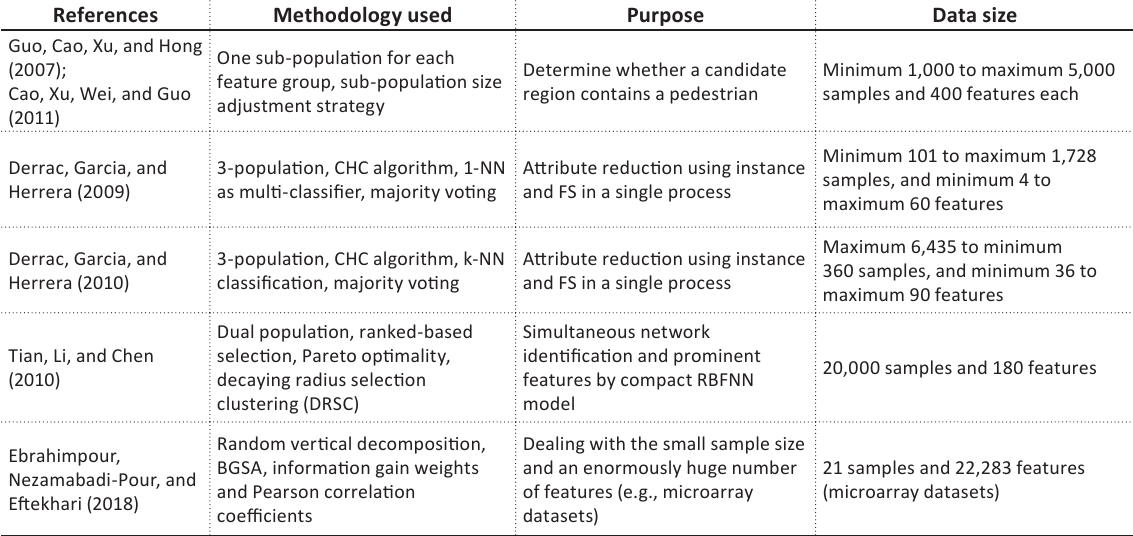
Table 1. Feature selection techniques based on cooperative co-evolution